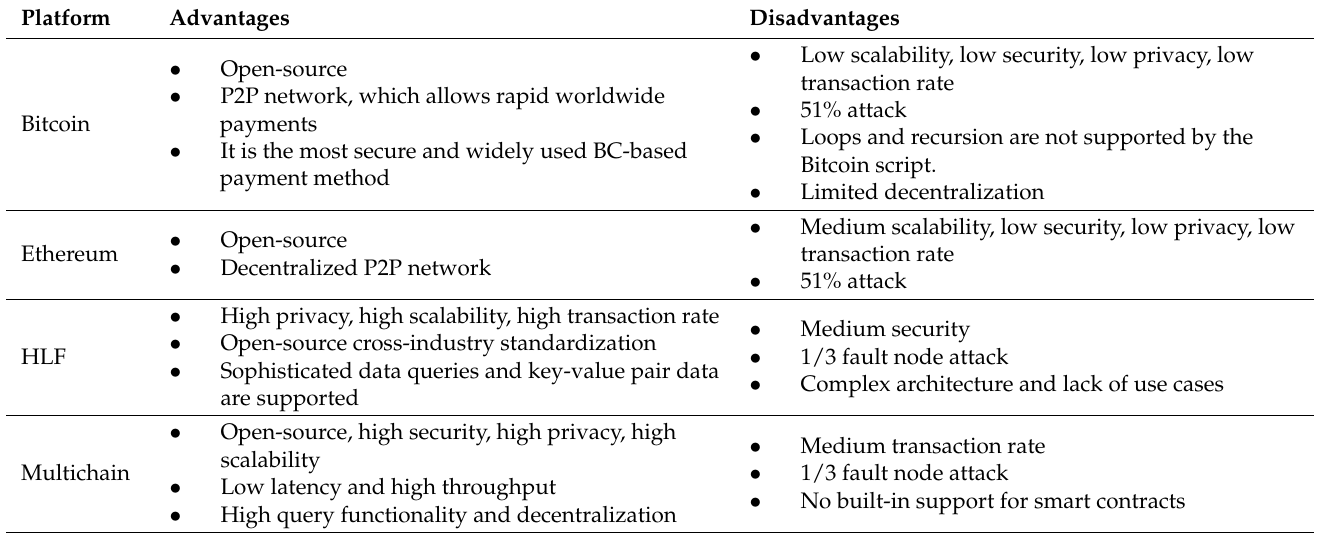
Table 3. Advantages and disadvantages of Bitcoin, Ethereum, HLF, and Multichain BCs’